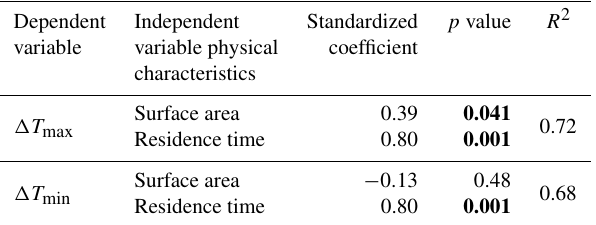
Table 4. Results of multiple linear regressions performed on the two indicators, (cid:49)T min and (cid:49)T max , using the dam physical charac- teristics surface area and residence time. Significant p values are shown in